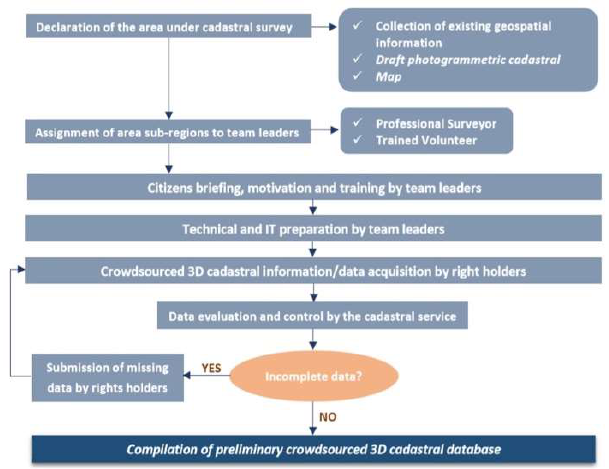
Figure 2. Crowdsourcing methodology for 3D cadastral surveys (Gkeli et al.,